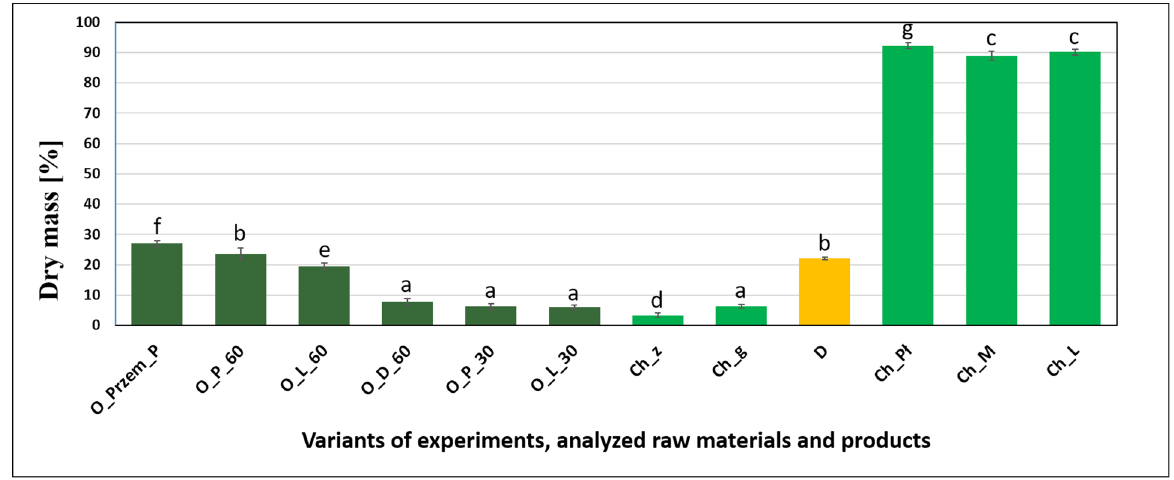
Figure 1. Dry matter of precipitated hot trub, yeast, and raw materials (n = 5, α = 0.05; homogeneous groups of results within a given parameter are marked with letters).